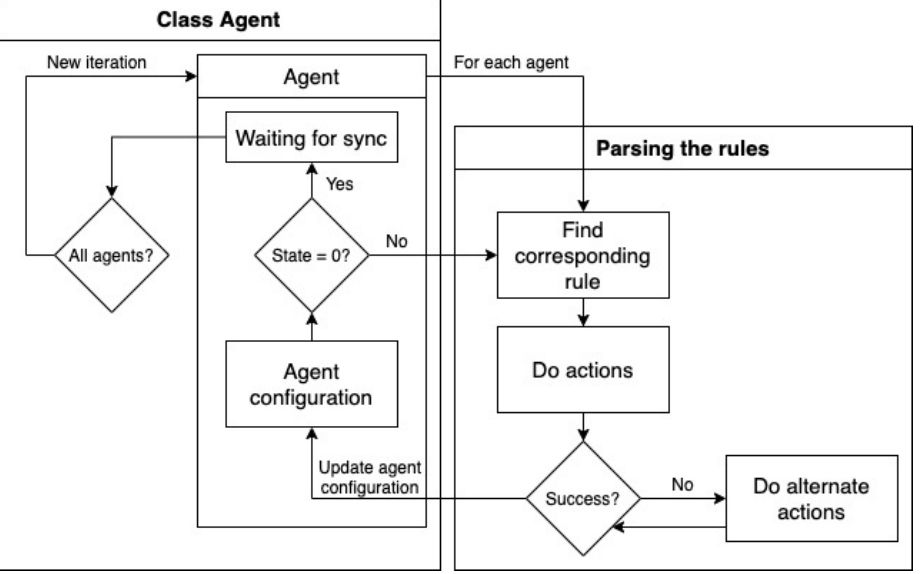
Figure 5. The updates of the configuration of the